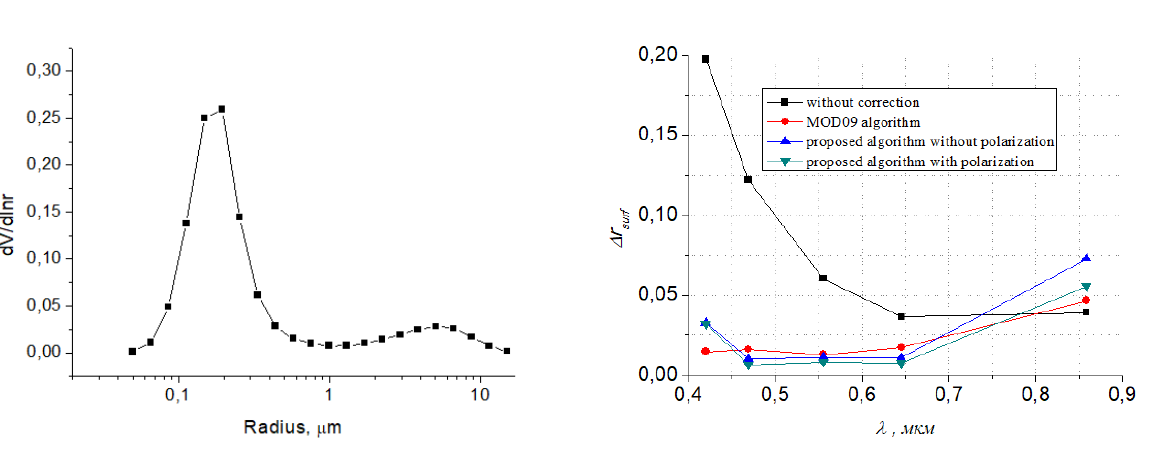
Figure 1. a-d) elements of aerosol scattering matrix r b) r , c) r , d) r , e) Particle size distribution function 12 13 14